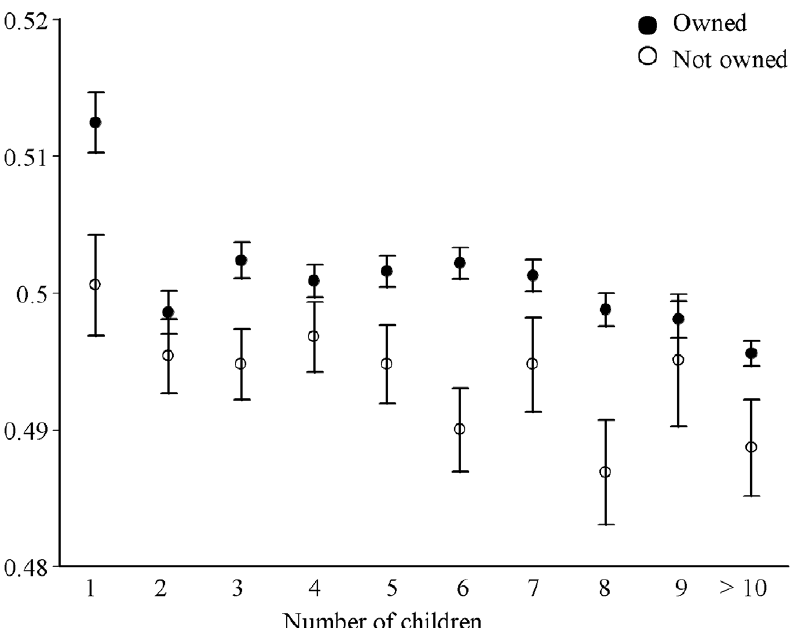
Figure 1. The overall SRB according to the number of children for mothers living in owned or not owned dwellings is shown. Values are mean 6 SE.